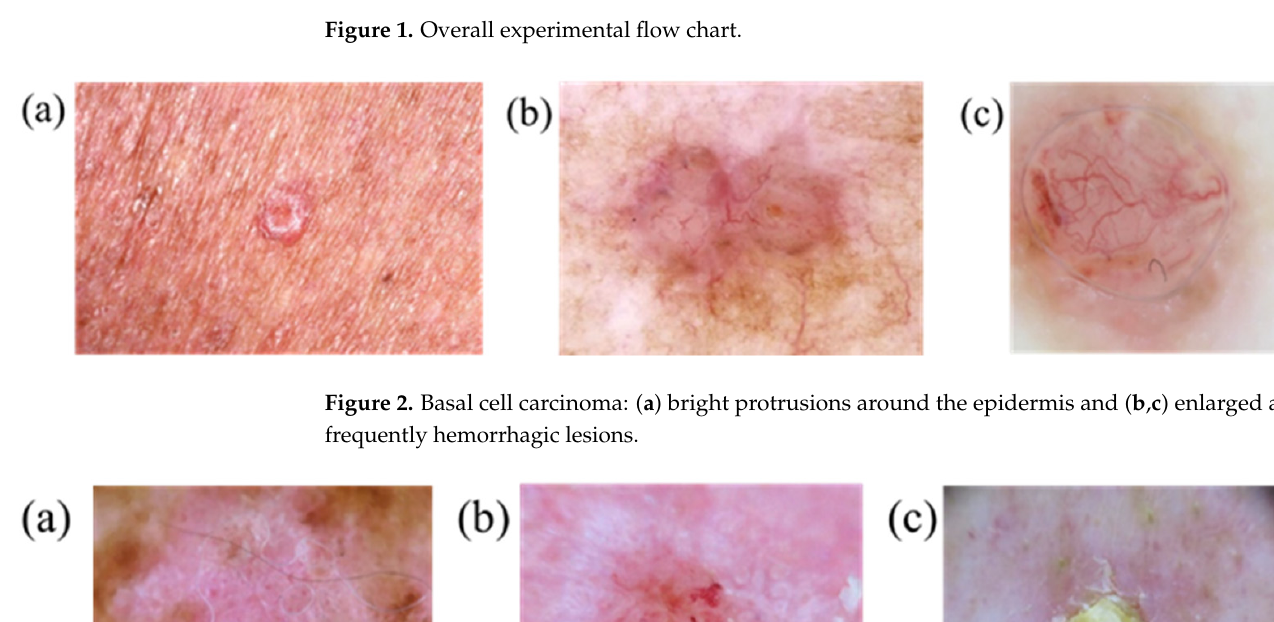
Figure 3. Squamous cell carcinoma appears as ( a , b ) red squamous plaques or ( c ) nodules.